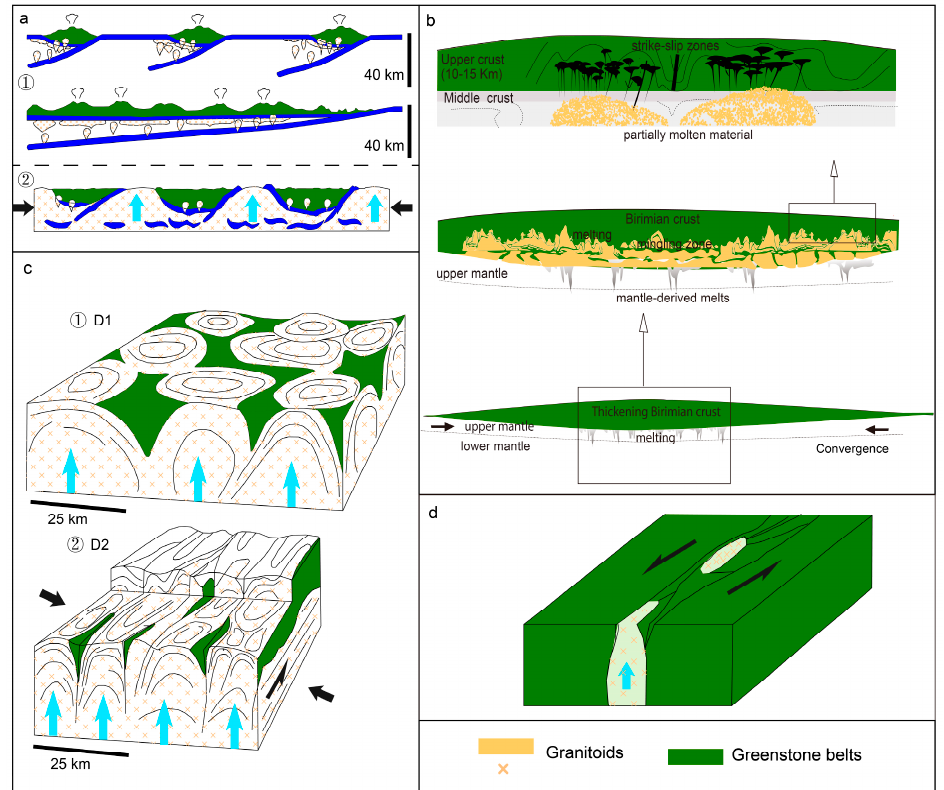
Figure 3. Different tectonic models accounting for the evolution of greenstone-granitoid belts in the Leo–Man Shield were proposed by ( a ) Baratoux et al. [1], ( b ) Ganne et al. [4] ( c ) Vidal et al. [16], ( d ) Feybesse et al. [18], respectively. Boundary conditions are indicated with black arrows. The upward motion of granitoids is indicated by blue arrows.